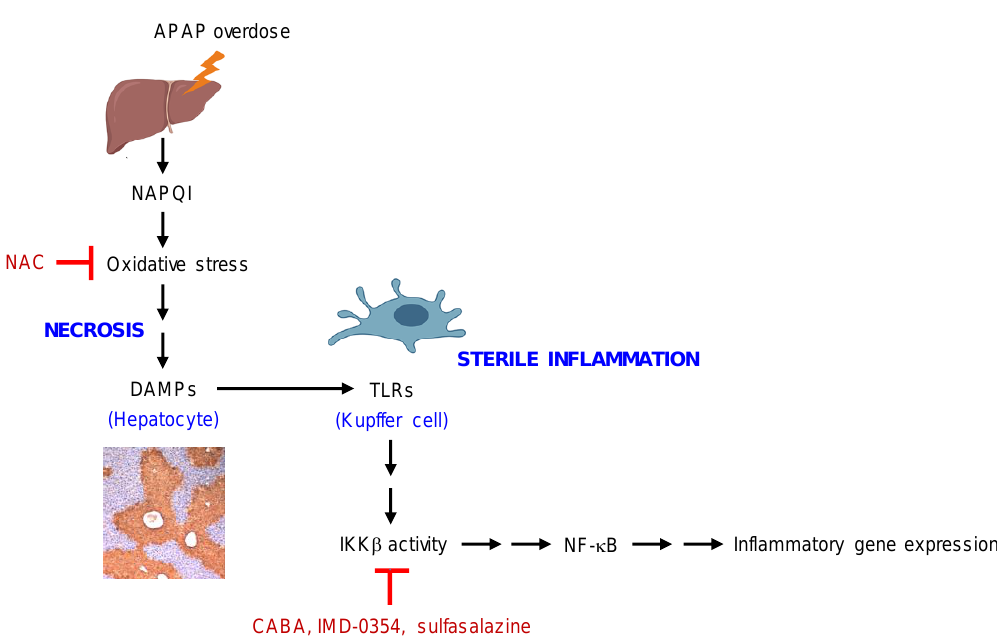
Figure 9. A proposed mechanism of IKKβ inhibition as an antidote against APAP overdose.